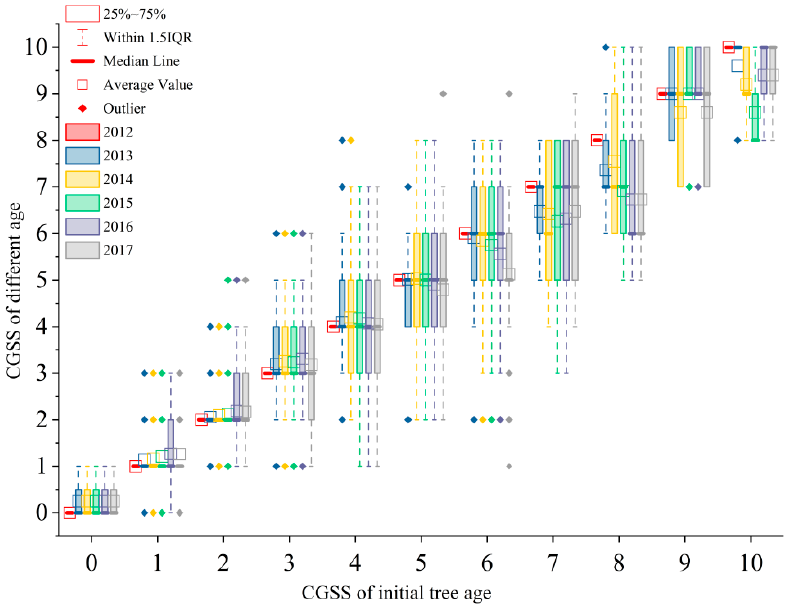
Figure 8. Comparison of CGSS of 1008 center trees at the initial stand age and CGSS at stand age changed. Table 6. Estimation and testing of parameters of Chinese fir morphological structure growth